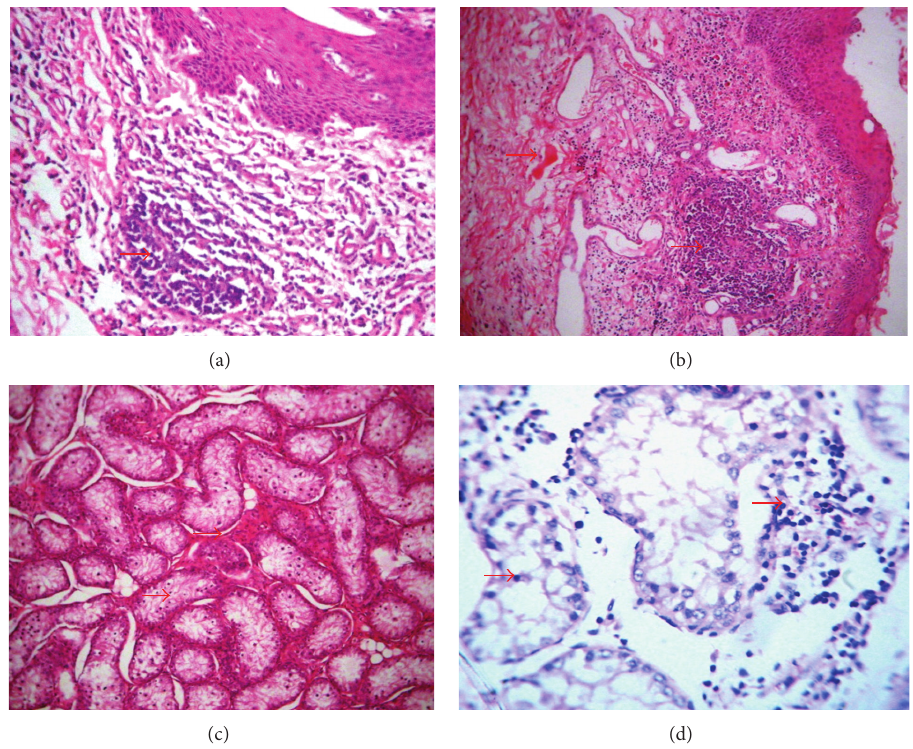
Figure 2: Histological section of the (a) preputial skin, showing marked leucocytic infiltration in inflammatory response in the dermis, H&E × 100, (b) preputial skin, showing hyperemia in the hypodermis and marked leucocytic infiltration in inflammatory response in the dermis, H&E × 40, (c) testis showing seminiferous tubules devoid of spermatogenic cell developmental stages, H&E × 100, and (d) testis showing atrophic seminiferous tubules with degenerate spermatocytes and inflammatory response in the interstitium, H&E × 200.